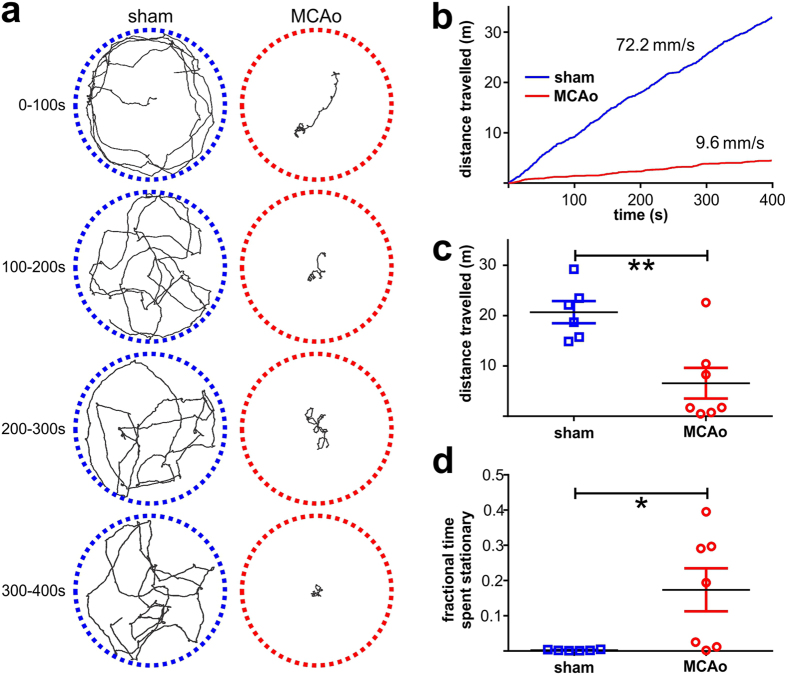
Analysis of locomotor activity in mice after experimental stroke using MouseMove.(a) Cumulative trajectories of a representative MCAo-operated mouse and a sham-operated mouse over 100 s intervals in the OF. (b) Plot of distance travelled over time for a representative sham- and MCAo-operated mouse in the OF. Numerical annotations indicate the mean speed for these same sham- and MCAo-operated mice over the 400 s period. (c,d) ‘Distance travelled’ (c) and ‘Fractional time spent stationary’ (d) for sham-operated (n = 6) and MCAo-operated (n = 7) mice over a 400 s period in the OF. Dot points represent the mean value for individual mice. Line and error bars represent the cohort mean ± s.e.m. **p < 0.01 and *p < 0.05 as determined by two-sided unpaired t-test without (c) or with Welch’s correction (d).